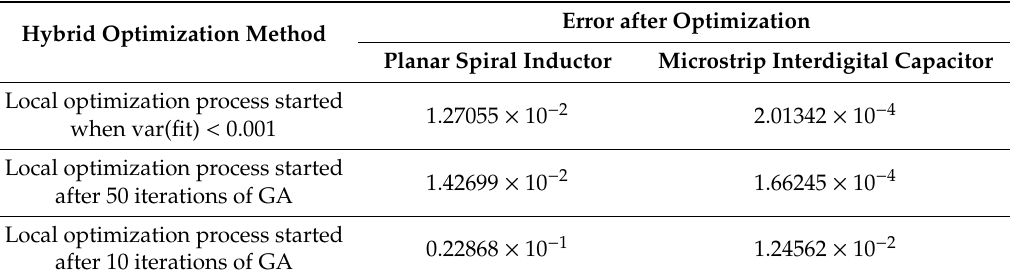
Table 7. Error of the objective function by three di ff erent hybrid optimization